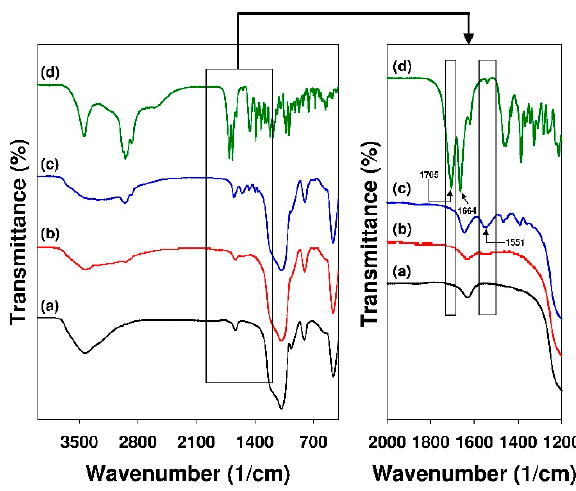
Figure 8. FT-IR spectra of ( a ) pure SBA-15, ( b ) SBA-15-AP, ( c ) SBA-15-AP + 18 β -GA, ( d ) 18 β -glycyrrhetinic acid (18 β -GA). The picture at the right shows details of the spectra.